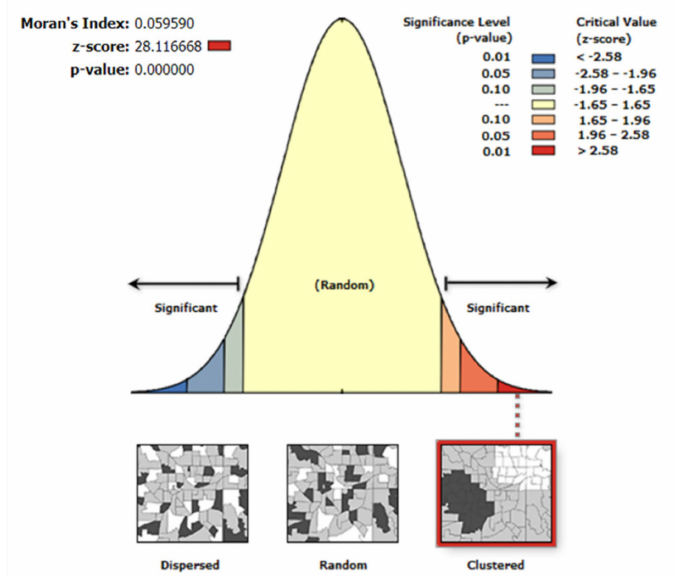
Figure 3. Results of global spatial autocorrelation analysis of the June imagery of Wuhan (generated by ArcMap